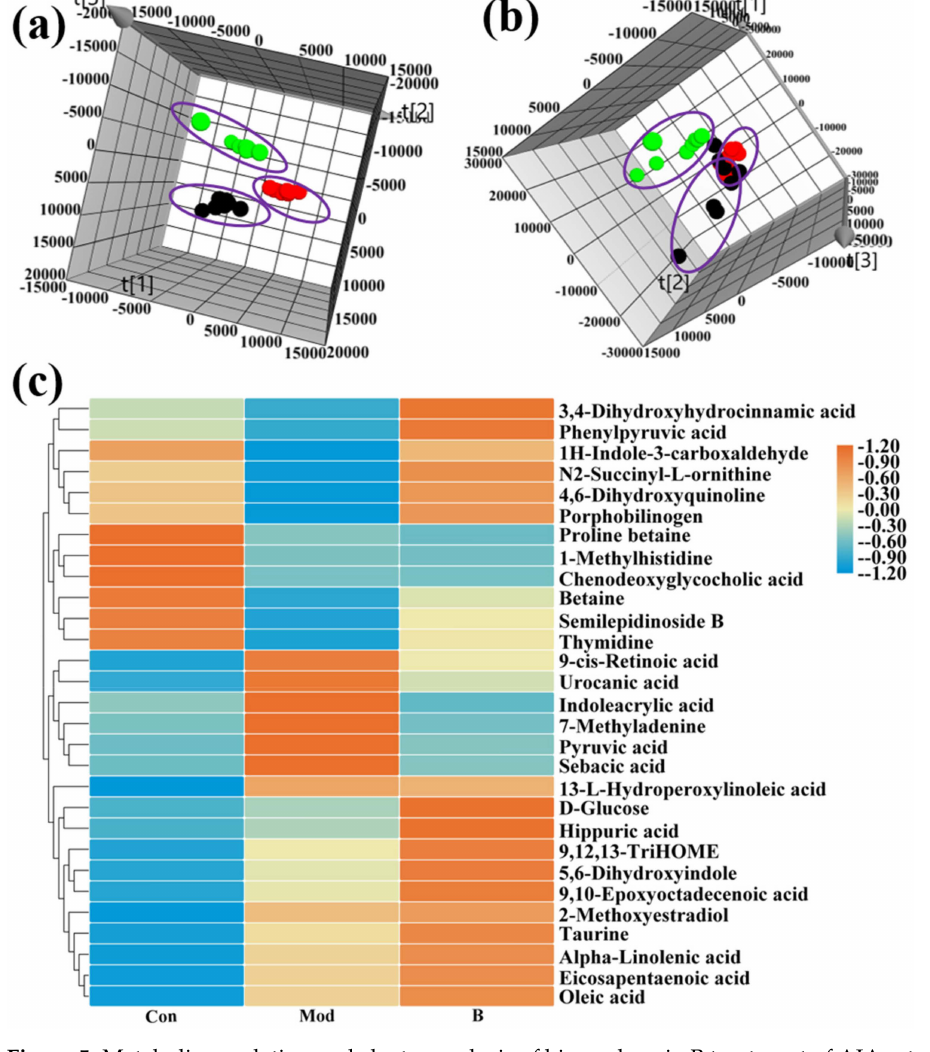
Figure 5. Metabolic regulation and cluster analysis of biomarkers in B treatment of AIA rats. Note: ( • ) = control group, ( • ) = model group, and ( • ) = Treatment group (B). ( a ) The 3D PCA scores plotted in positive mode. ( b ) The 3D PCA scores plotted in negative mode. ( c ) Euclidean Cluster analysis of biomarker